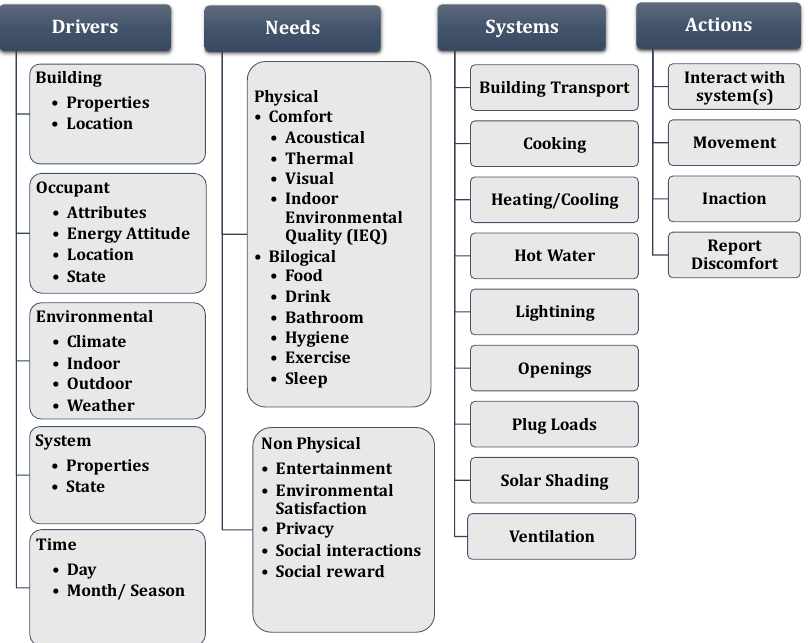
Figure 9. OB Technical Framework. Adapted with permission from ref. [41]. Copyright 2015